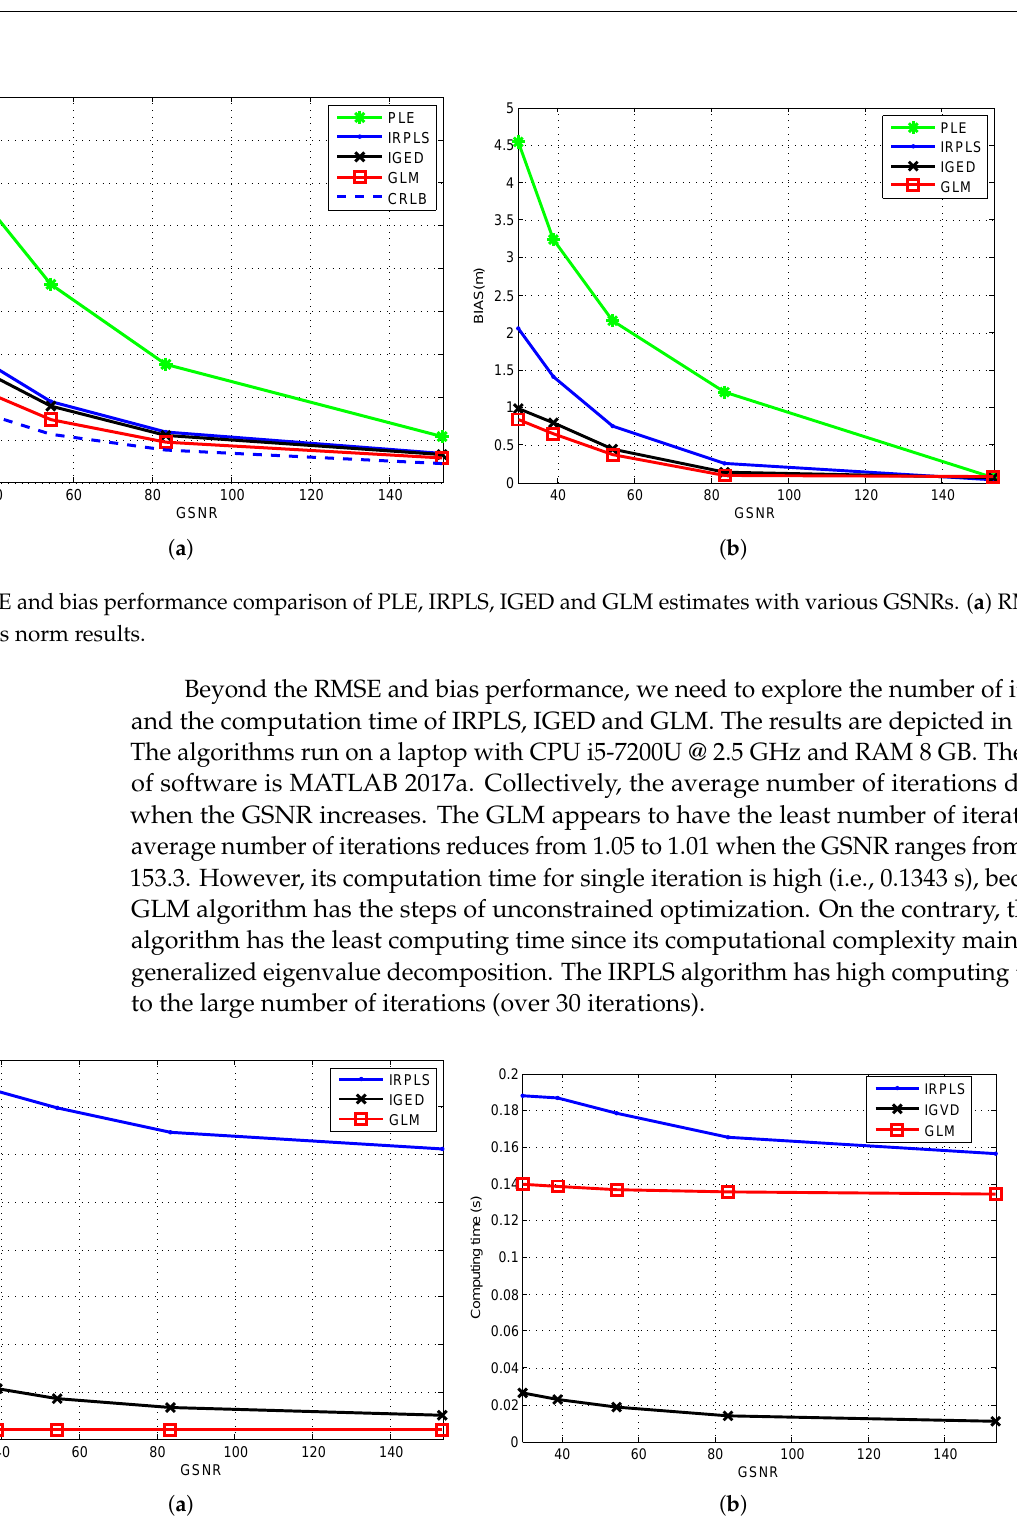
Figure 5. Number of iterations and computing time versus GSNR for the IRPLS, IGED and GLM algorithms. ( a ) Number of iterations. ( b ) Computing